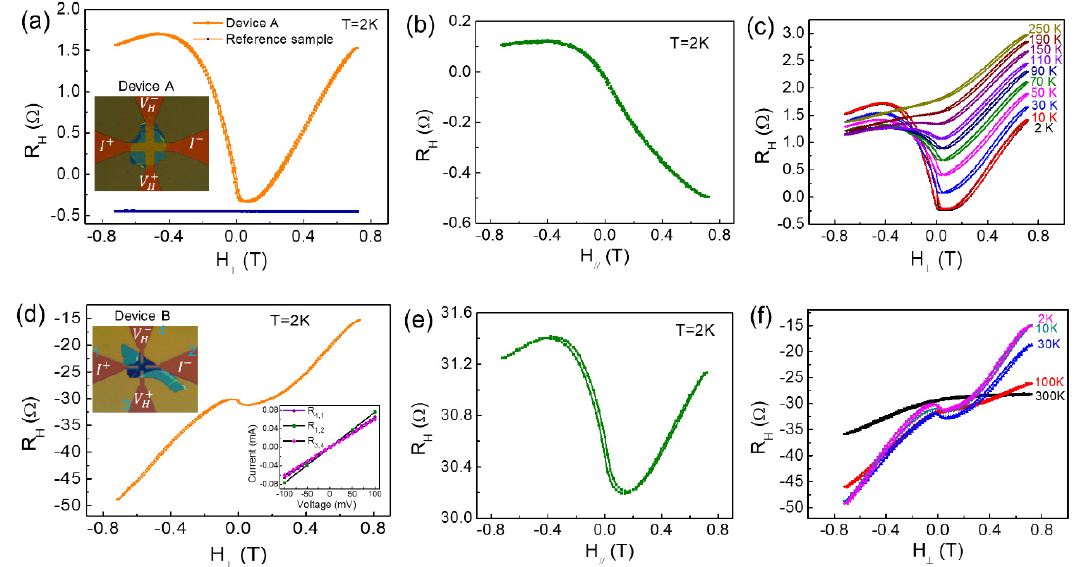
Figure 4. ( a , b ) Hall magnetoresistance of device A consisting of a CrBr 3 flake on Pt Hall bar electrodes under out-of-plane and in-plane magnetic fields, respectively. The Pt Hall bar device was used as the reference sample. The CrBr 3 film is shown in the teal-colored area. ( c ) Temperature dependence of Hall magnetoresistance of device A. ( d , e ) Hall magnetoresistance of device B consisting of a CrBr 3 flake on of Pt Hall bar electrodes without a crossing area. Inset of ( d ): linear I–V curves of CrBr 3 flake. The numbers 1, 2, 3, 4 are used to mark four electrode ports. ( f ) Temperature dependence of Hall magnetoresistance of device B.